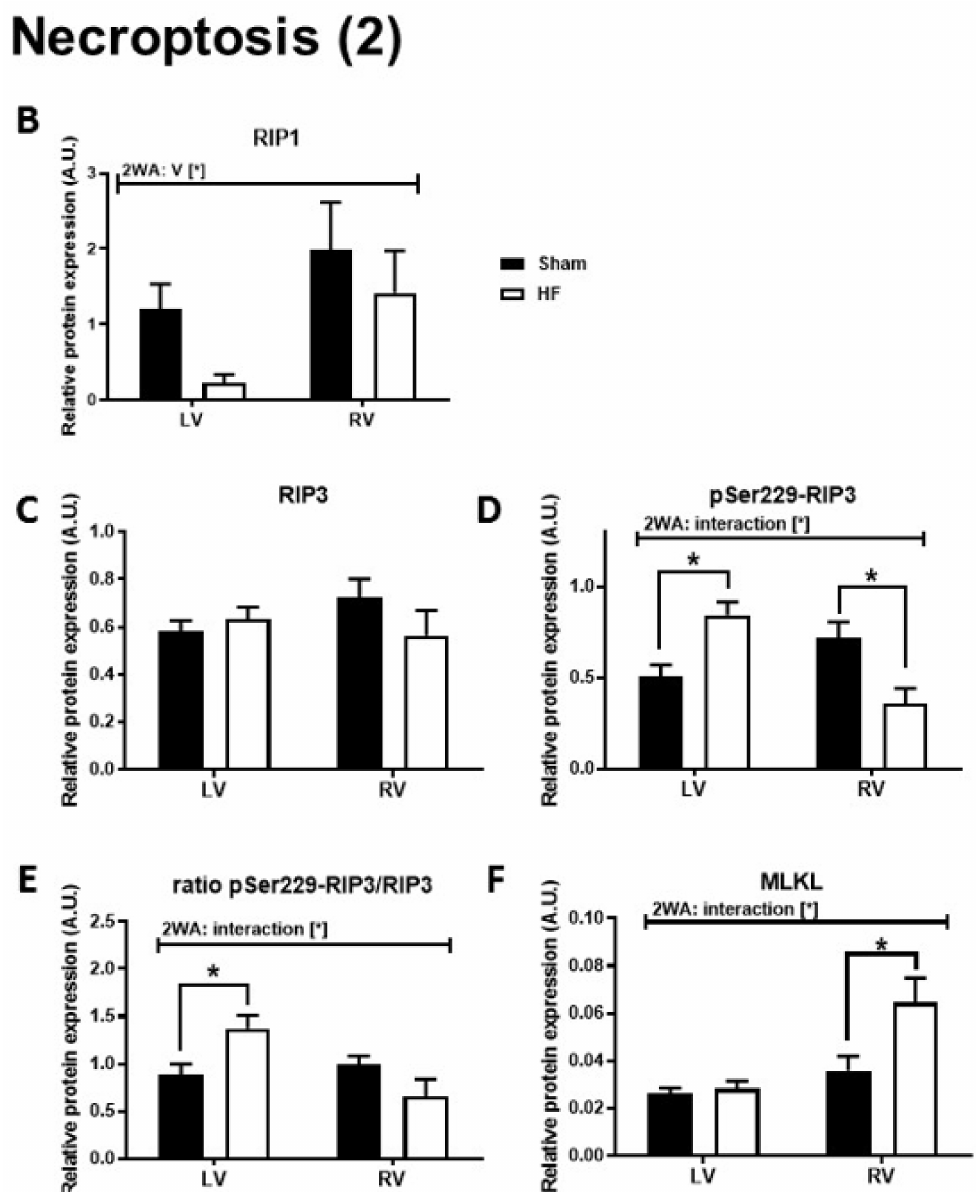
Figure 1. Analysis of necroptotic signaling in the left and right ventricle of rat hearts. ( A ) representative immunoblots and total protein staining; ( B – F ) Immunoblot quantification of RIP1, RIP3, pSer229-RIP3, ratio pSer229-RIP3 / RIP3 and MLKL. Sham—sham-operated group; HF—group with post-myocardial infarction heart failure; LV—left ventricle; RV—right ventricle. Data are presented as mean ± SEM; n = 6–9 per group; 2WA—2-way ANOVA; “HF” factor—presence of heart failure; “V” factor—heart ventricle; “Interaction” of 2 factors. * p < 0.05 vs.